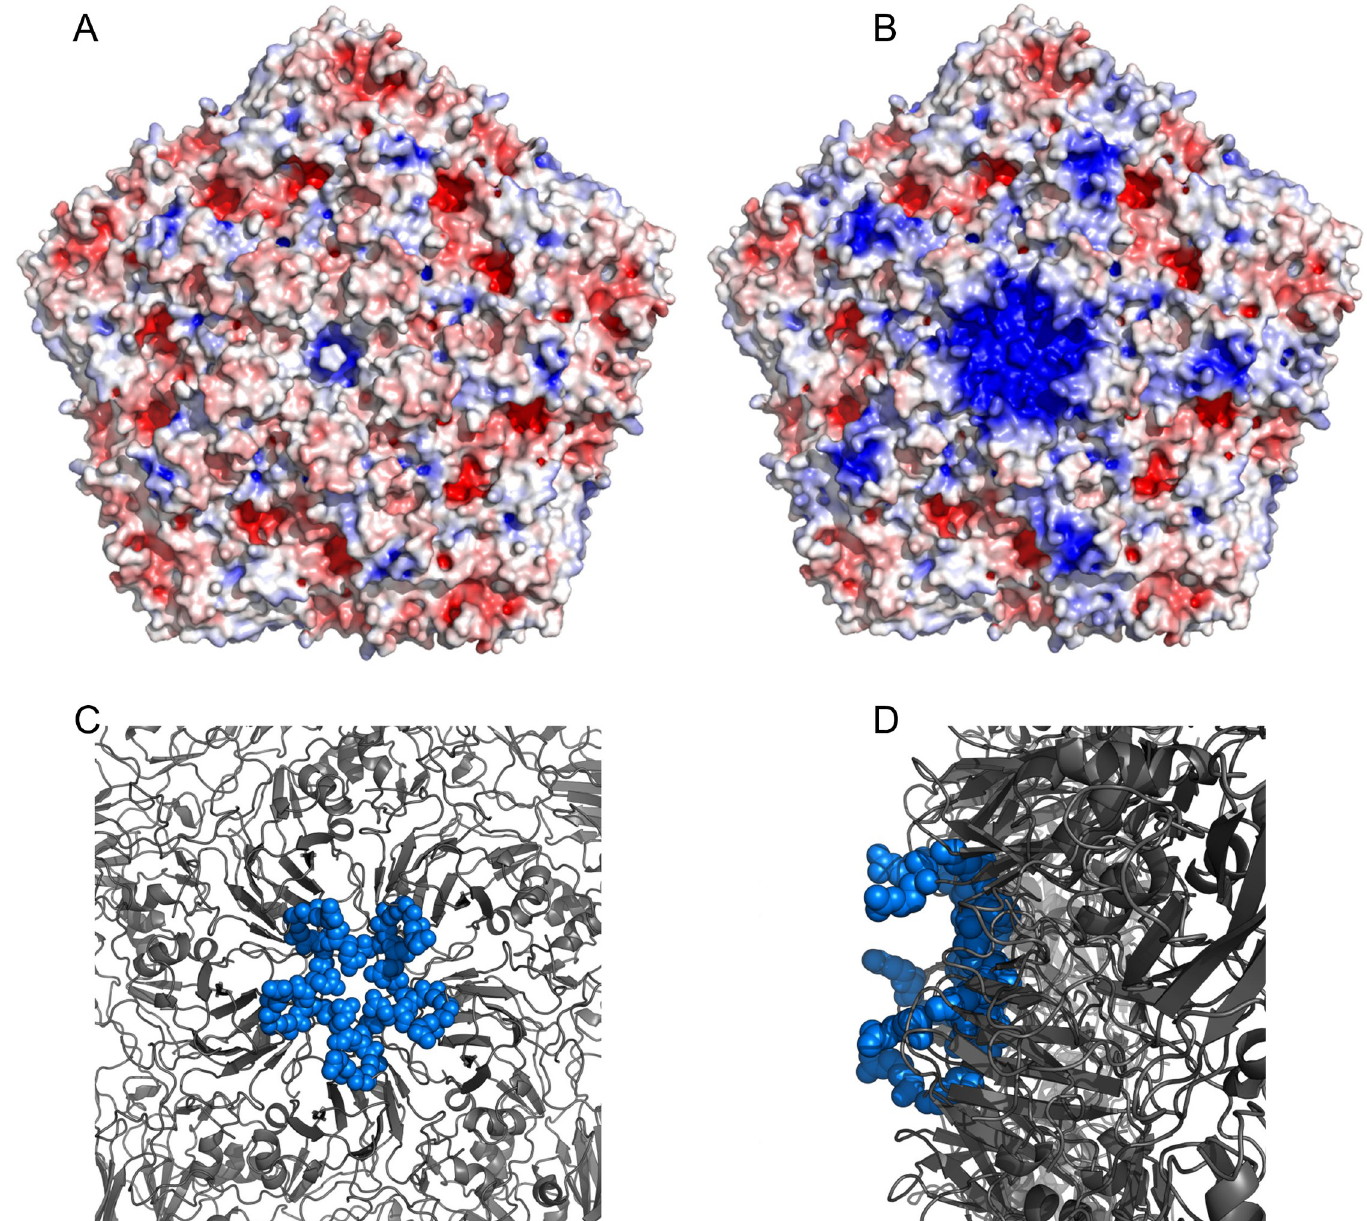
Fig 3. Charge distribution and clustering of mutations on the capsid surface. ( A ) Electrostatic potential of wild-type SAT1 capsid showing uniform charge distribution on the particle surface. ( B ) Electrostatic potential of the mutant SAT1 capsid showing clustering of positive charge at the 5-fold axis. The electrostatic potential was calculated using the APBS plugin embedded within Pymol. The colouring represents positive charge (blue), negative charge (red) and neutral (white). ( C ) The projection of the capsid on a 5-fold axis shows the clustering of the positively charged mutations from the top view. ( D ) The projection showing the side view and the surface exposure of the mutant side